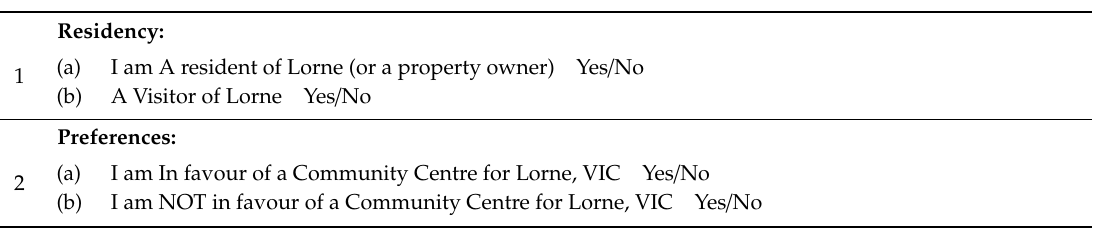
Table 2. Listening Post